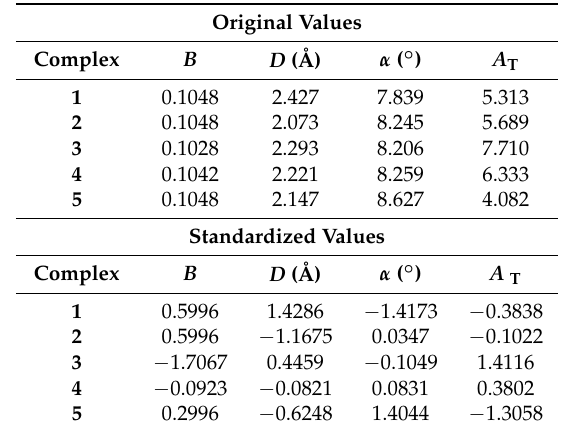
Table 2. The original and standardized values of bond order ( B ), minimum distance ( D ) and dihedral angle ( α ) for complexes 1 – 5